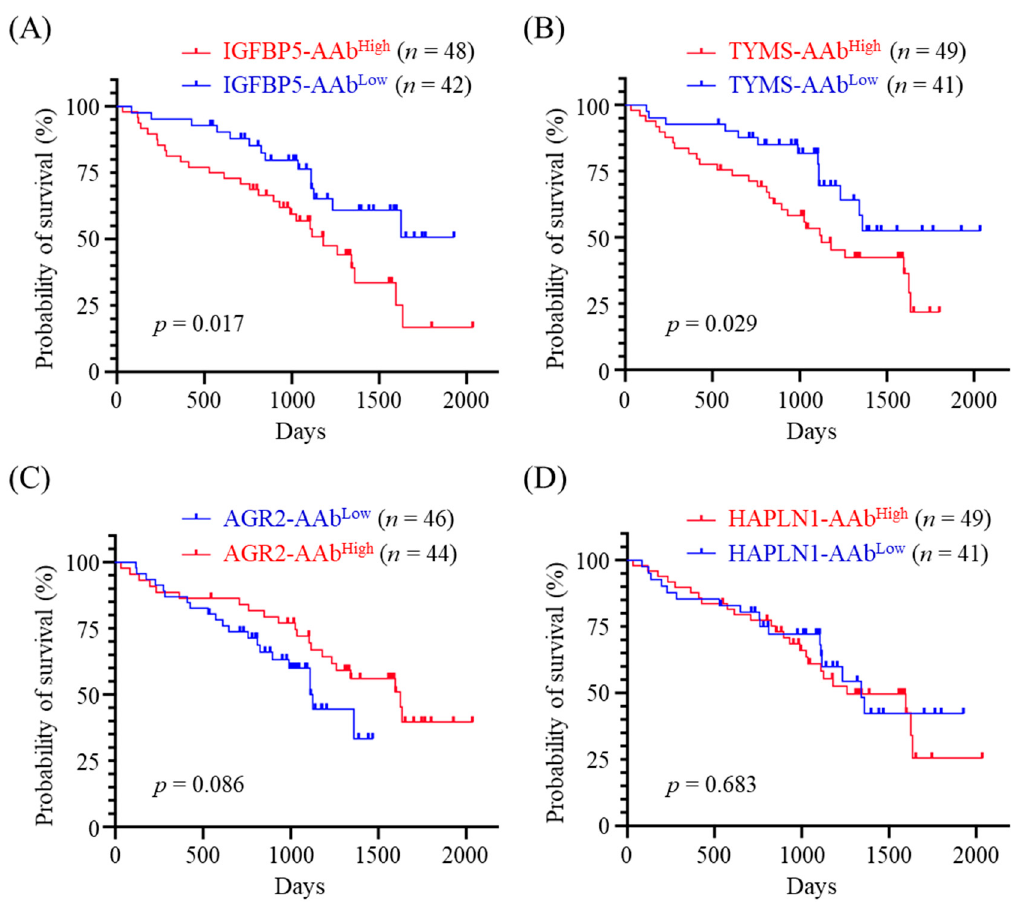
Figure 3. Correlation between serum AAb levels and overall survival time (OST) of CMT dogs. Ninety CMT dogs were divided into two groups exhibiting low and high serum levels of ( A ) IGFBP5-AAb, ( B ) TYMS-AAb, ( C ) AGR2-AAb, and ( D ) HAPLN1-AAb, respectively. Comparison of OST between the two groups was carried out by using Kaplan-Meier analysis. Statistical significance was determined by the log-ranked test.